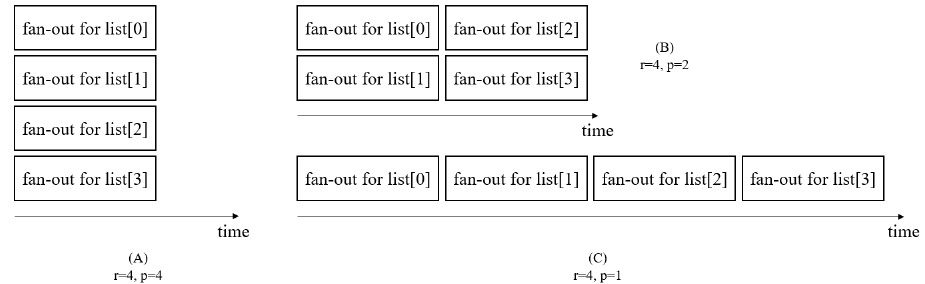
Figure 5. Execution pattern of the fan-out according to the maximum concurrency. The length of the input list is 4. ( A ) When maximum concurrency is the same as the number of requests, all processes can be run simultaneously. ( B ) If the maximum concurrency is half of the number of the requests, the execution time is twice that of ( A ). ( C ) If the maximum concurrency is 1, it is the same as a sequential